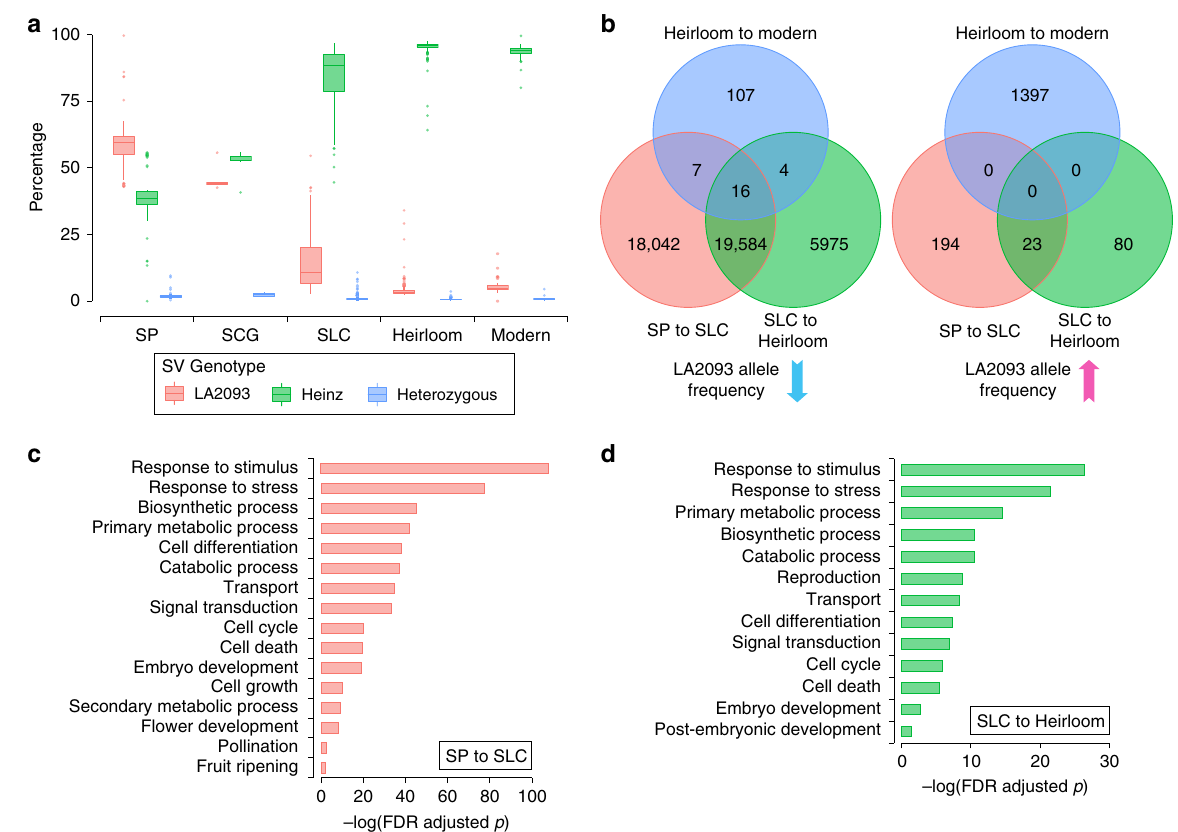
Fig. 2 SVs under selection during tomato domestication and breeding. a Percentages of SVs with different genotypes in each accession of different groups. The numbers of accessions are 50, 6, 224, 225, and 51 in SP, SCG, SLC, Heirloom, and Modern groups, respectively. For each box plot, the lower and upper bounds of the box indicate the fi rst and third quartiles, respectively, and the center line indicates the median. The whisker represents 1.5× interquartile range of the lower or upper quartile. b Venn diagrams of selected SVs during domestication (SP to SLC), improvement (SLC to heirloom) and modern breeding (heirloom to modern). c , d GO terms enriched in genes affected by SVs selected during domestication ( c ) and improvement ( d ). Enriched GO terms were identi fi ed using two-tailed Fisher ’ s exact test, adjusted for multiple comparisons. Source data underlying Fig. 2a are provided as a Source data fi